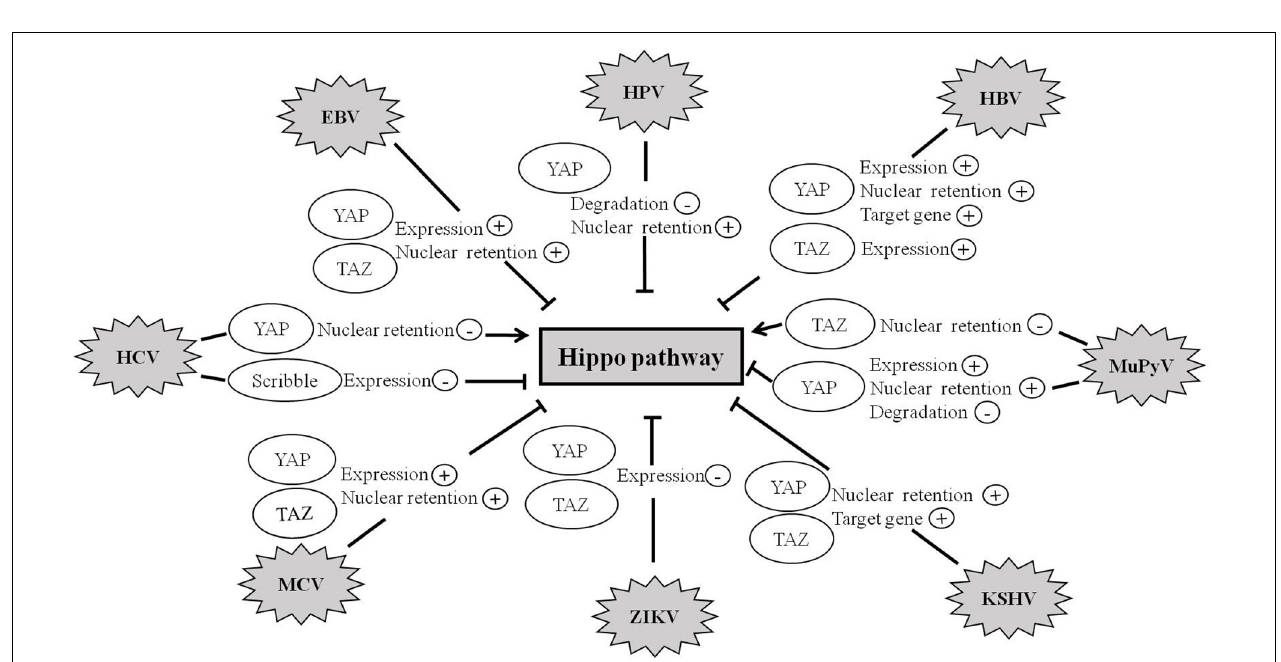
FIGURE 4 | Hippo pathway is involved in viral infection. Abnormal regulation of the Hippo pathway has been observed during infection with a variety of viruses such as HBV, HCV, MCV, ZIKV, EBV, KSHV, HPV, and MuPyV. Viruses exert their carcinogenic function by regulating the expression, degradation, and nuclear retention of YAP/TAZ